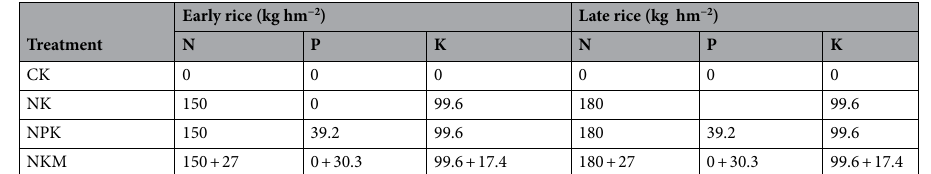
rice plants from five random hills in each plot were collected, dried at 65 °C, weighted, separated into grains and straw, and then ground for further analysis. Approximately 0.2 g of the ground plant samples was used to